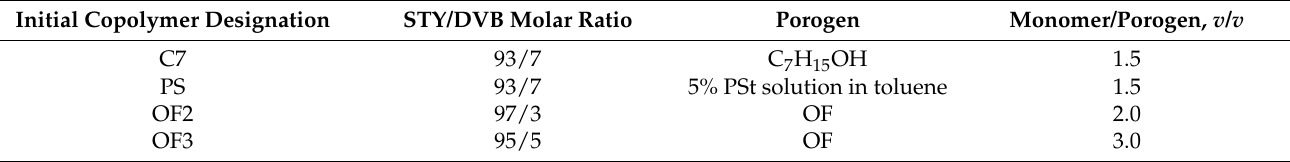
Table 2. The composition of the organic